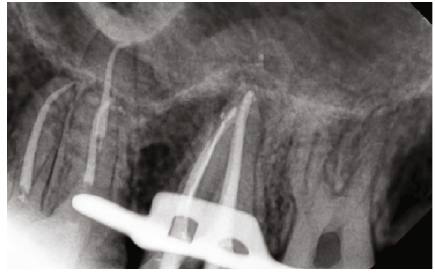
Figure 7: Periapical due to upper 7 obturation.